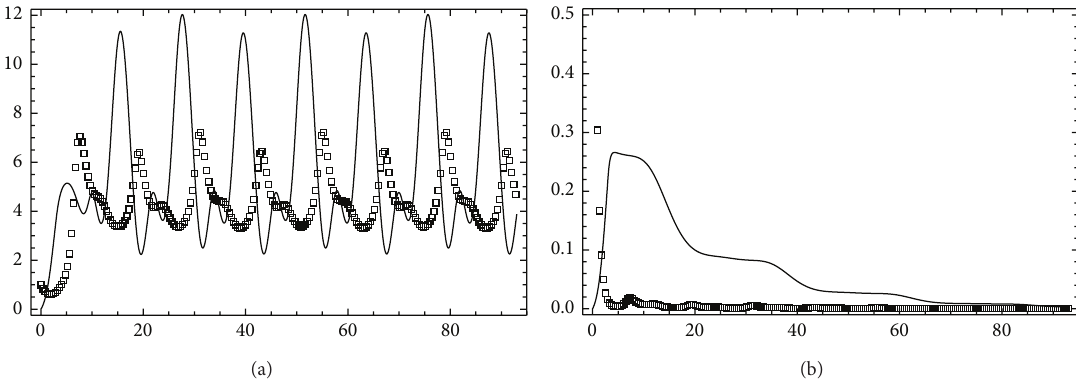
Figure 1: A periodic solution ((a) 𝐴 = 1 , 𝐵 = 2.4 , and 𝑟 = 0.2 satisfy the conditions of Theorem 6) and a solution tending to zero ((b) 𝐴 = 0.2 , 𝐵 = 0.02 , and 𝑟 = 1.5 satisfy the conditions of Theorem 7), where square is 𝑥(𝑡) , line is 𝑦(𝑡) , 𝑦